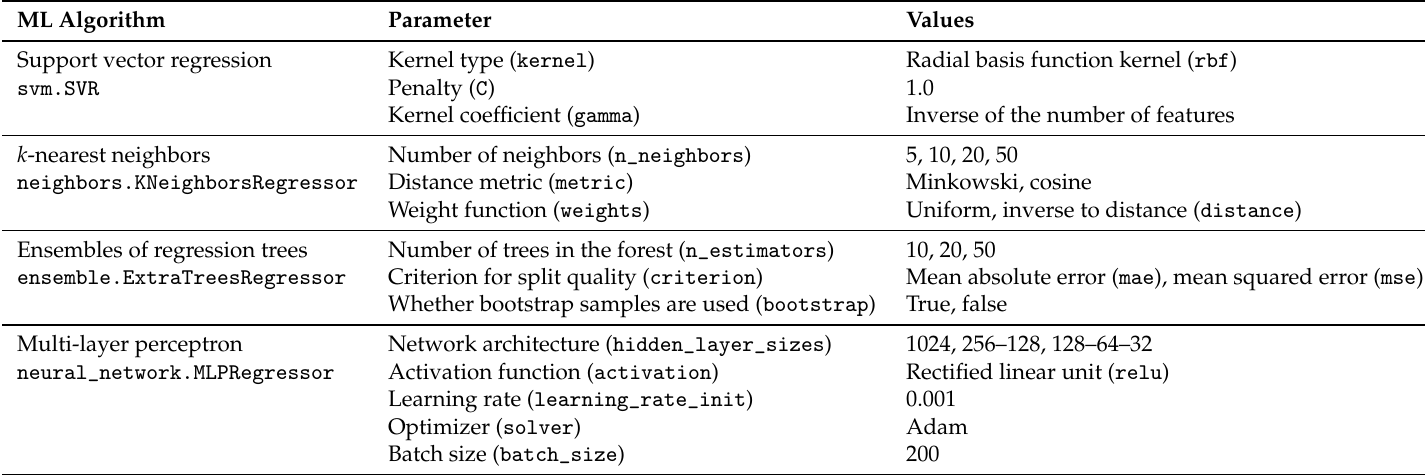
Table 3. Configuration in scikit-learn of the different machine learning algorithms that will be used for addressing the regression